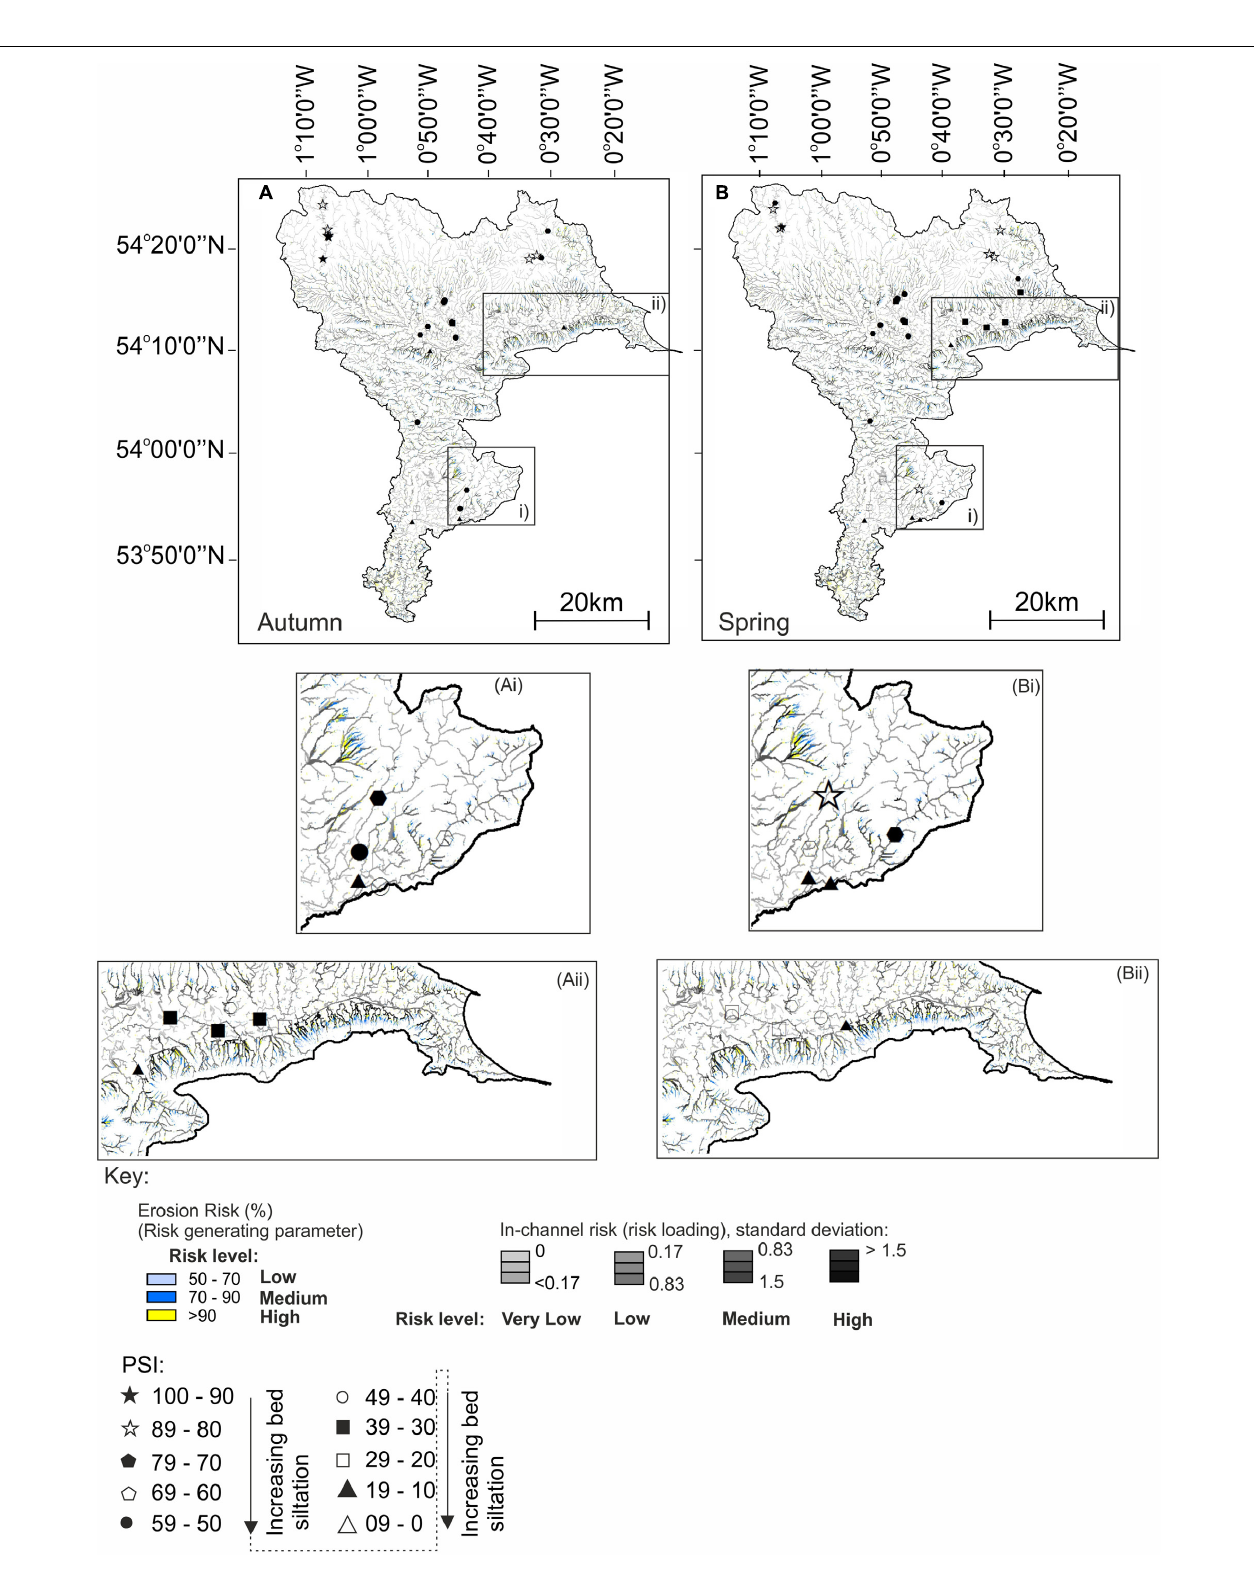
FIGURE 10 | Variation in sediment sensitive species in (A) autumn and (B) spring across the year, the base maps show the erosion risk when using the long term average rainfall scenario ( Table 2 ). Inserts show higher resolution study areas from (A,B) . Locations are shown on each map; Pi, Pickering; M, Malton; Po, Pocklington; E, Elvington; B,